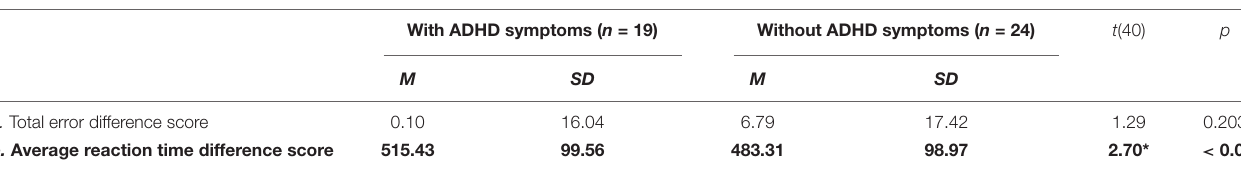
TABLE 4 | Sustained attention to response t